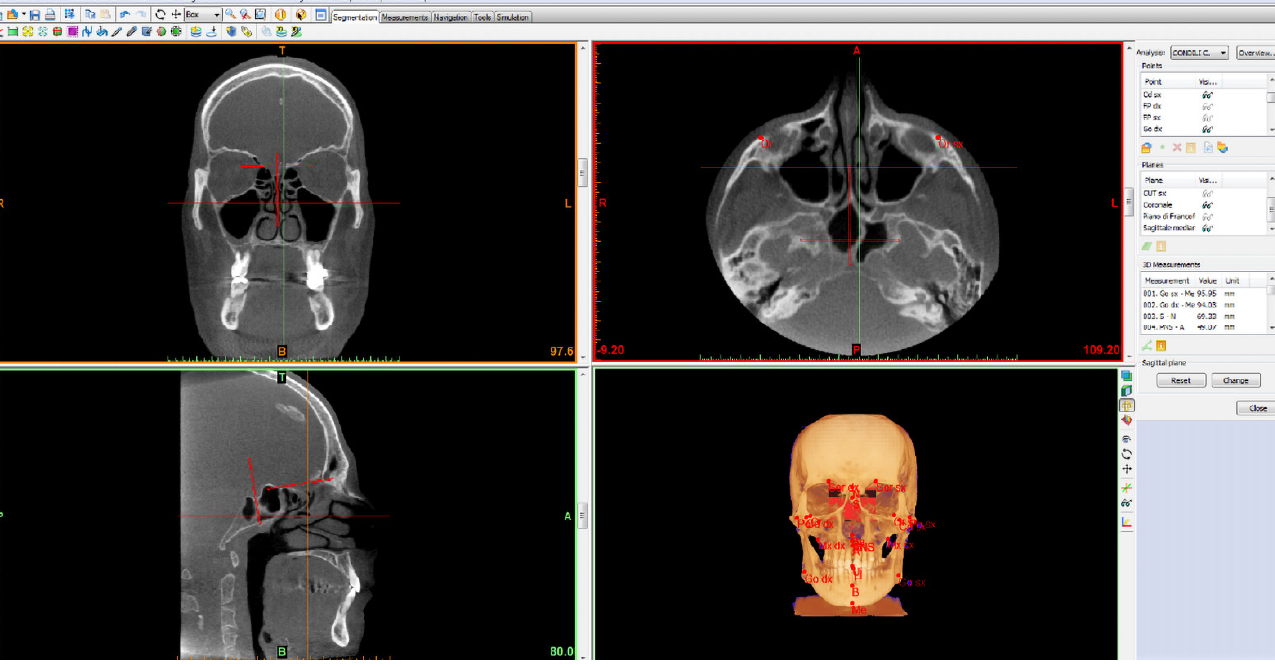
Figure 1. 3D cephalometric analysis using the 18-point protocol of the School of Specialization in Orthodontics of the University of Milan, Fondazione IRCCS Ca’ Granda, Ospedale Maggiore Poli-